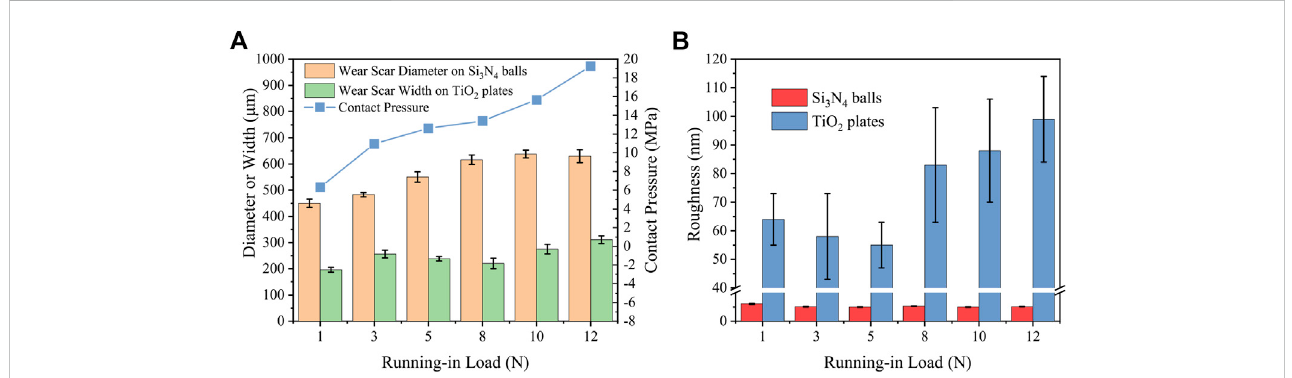
FIGURE 5 Whentherunning-inspeedwas0.056 m/sandrunning-indistancewas16.96 m, (A) changeinwearscardiametersonSi 3 N 4 ballsandwearscarwidthon TiO 2 platesandthecorrespondingcontactpressurewiththeincreaseinrunning-inload; (B) roughnesschangeonSi 3 N 4 ballsandTiO 2 plateswiththeincrease in the running-in load.